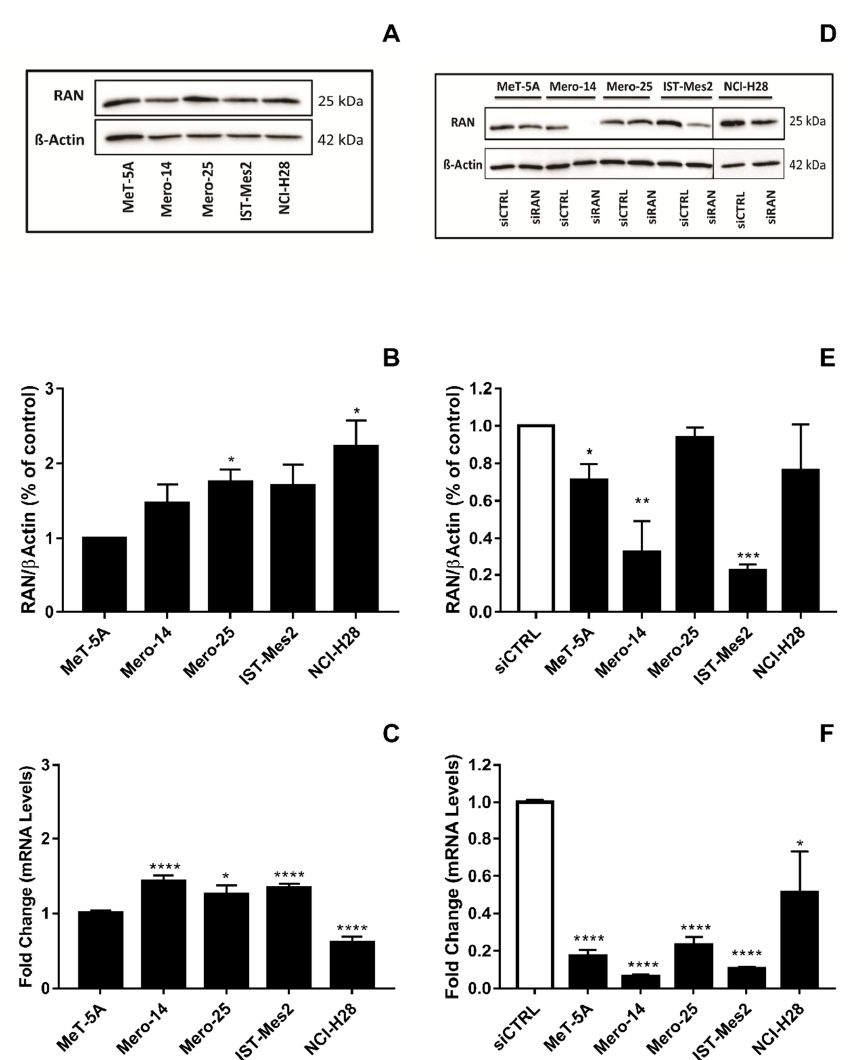
Figure 5. Expression of RAN in non-malignant MeT-5A and a panel of MPM cells, as Mero-14, Mero-25, IST-Mes2, and NCI-H28. ( A ): Picture representing basal protein levels of RAN. β -Actin was used as reference. The present picture is representative of one of two experiments performed. ( B ): Histogram reporting protein levels of RAN, normalized to β -actin. The histogram was generated by quantifying blots from two independent experiments and normalizing the intensity of the bands to the MeT-5A lane. ( C ): RT-qPCR showing fold changes of mRNA basal levels of RAN , measured in MPM cell lines and related to the MeT-5A, set to one. RPLP0 , HPRT1 , and TPB were used for normalization. ( D ): Picture representing protein levels of RAN, after its depletion through siRAN-1. β -Actin was used as reference. The present picture is representative of one of two experiment performed. The grouping of blots cropped from di ff erent parts of the same gel, or from di ff erent gels, is made explicit using a black line delineating the boundary between the gels. ( E ): Histogram reporting protein levels of RAN normalized to β -actin. The histogram was generated by quantifying blots from two independent experiments and normalizing the intensity of the bands to the siCTRL lane. ( F ): RT-qPCR showing, as fold change, the mRNA expression levels of RAN , after treatment with siRAN-1, related to their own siCTRL. RPLP0 , HPRT1 , and TPB were used for normalization. Error bars are SEM, from three independent experiments, each performed in triplicate. Statistical significance is indicated by asterisk (*), where * p < 0.05; ** p < 0.01; *** p < 0.001, **** p <